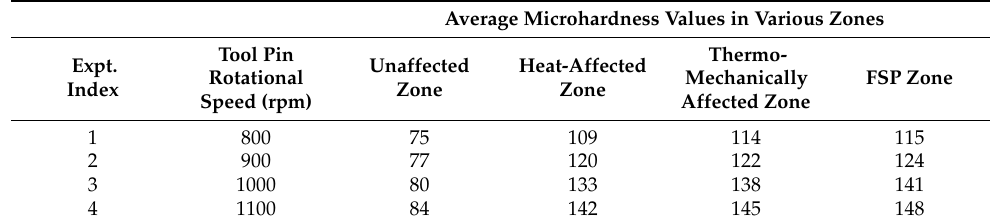
Table 4. Microhardness for the various zones of the FSP using different tool speeds.